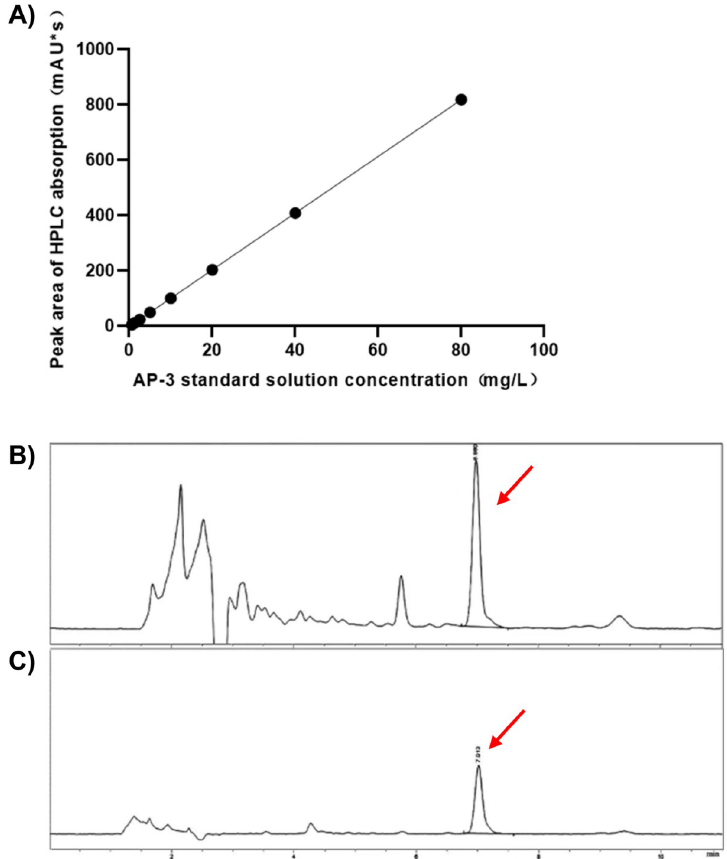
Fig 2. HPLC analysis of AP-3 production. (A) AP-3 standard curve. (B) Products of the fermentation sample. (C) AP-3 standard. Red arrows indicate the AP-3 position in the graphs.